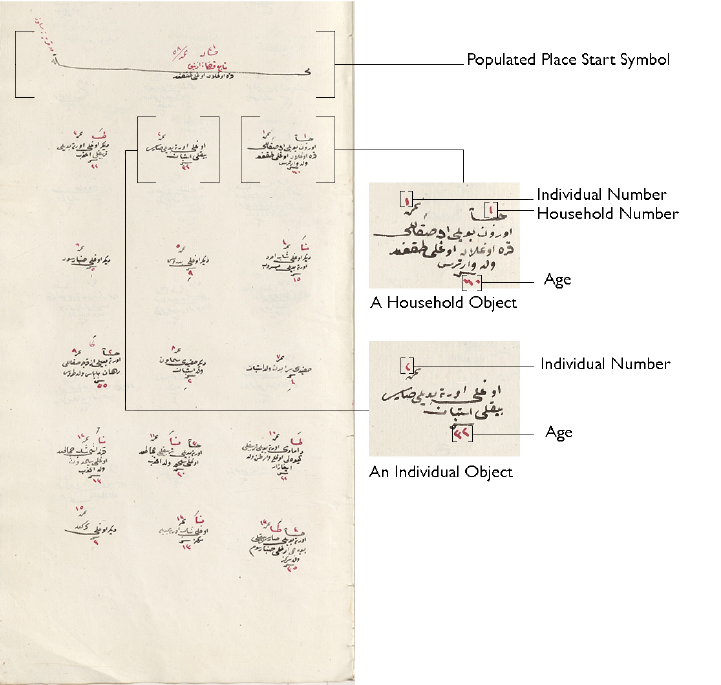
Figure 1. A sample register page and individual object are demonstrated. The individual and household numbers are written in the top of the individual data and ages are written in the last lines. For estimating the age distribution, we selected three neighborhoods from Manisa city with respective numbers of registered persons: Sultan (120), Çar¸sı (68), and Gürhane (225). They contain a total of 413 people and their ages are